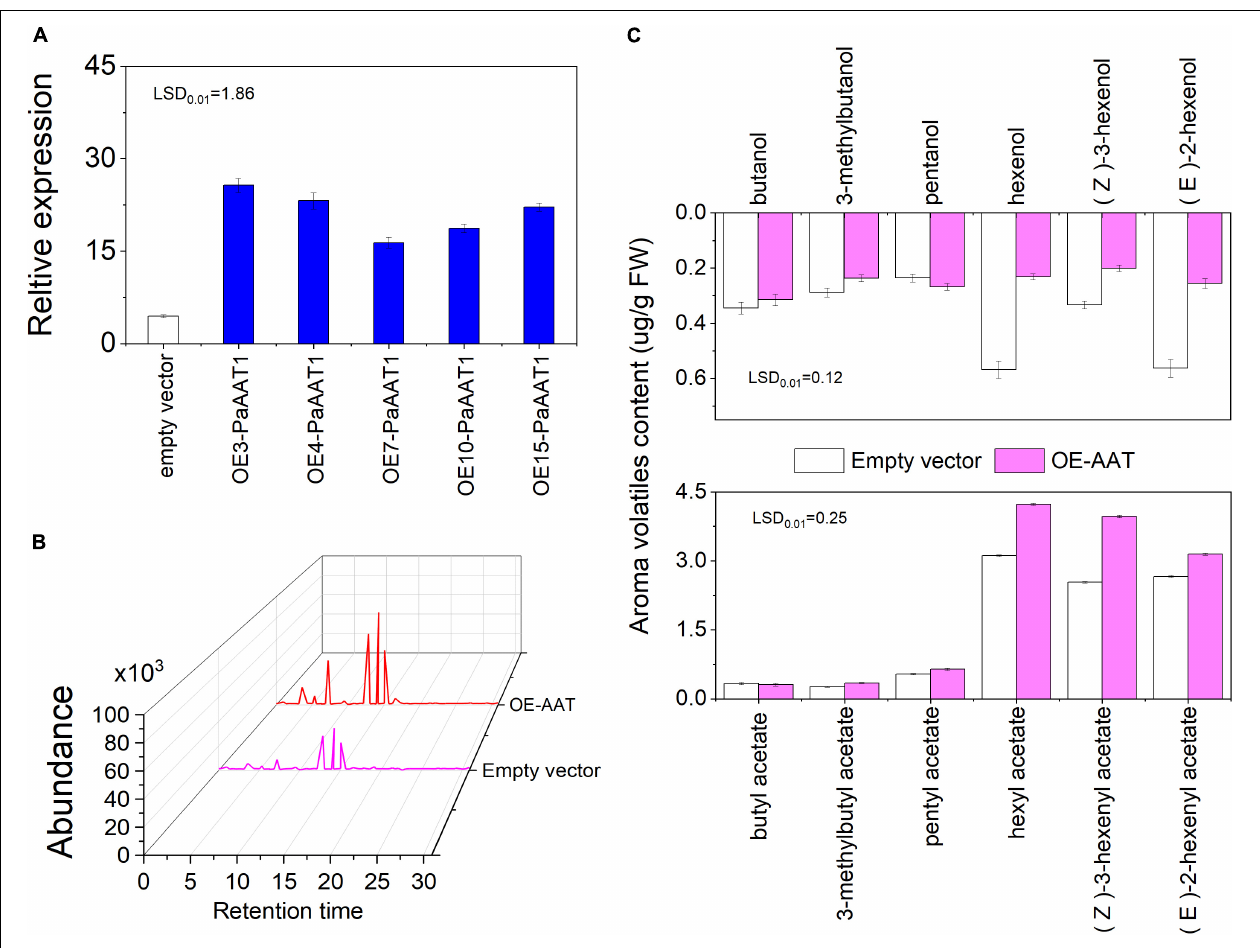
FIGURE 5 | Transient expression of PaAAT1 in KT fruit; (A) expression of PaAAT1 infiltrated with an empty vector and PaAAT1; (B) chromatogram of esters in peel infiltrated with an empty vector and PaAAT1; (C) volatile alcohols and esters emitted from the peel injected with an empty vector and PaAAT1. LSD, least significant difference ( p < 0.01).